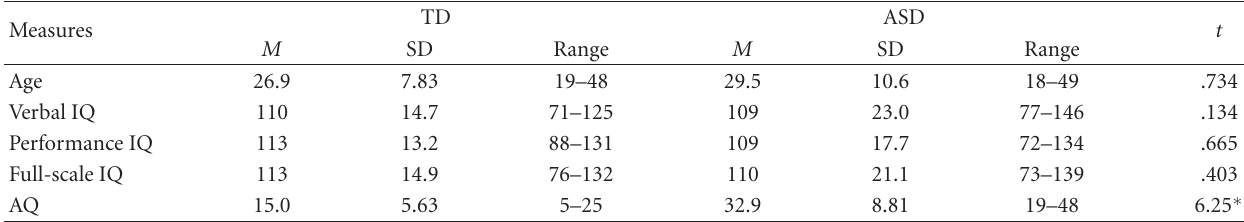
Table 1: Means, standard deviations, and range of age, verbal IQ, performance IQ, full-scale IQ, and AQ scores for ASD and TD group.